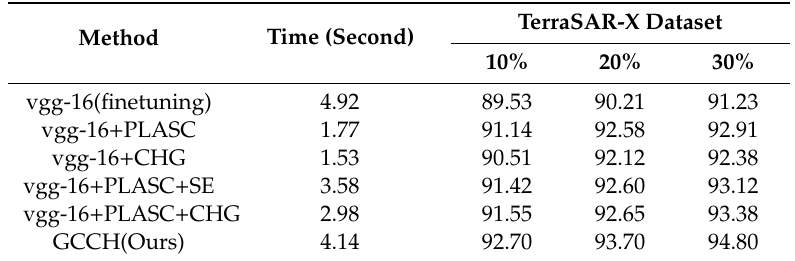
Table 5. The ablation and combined experiments of the GCCH